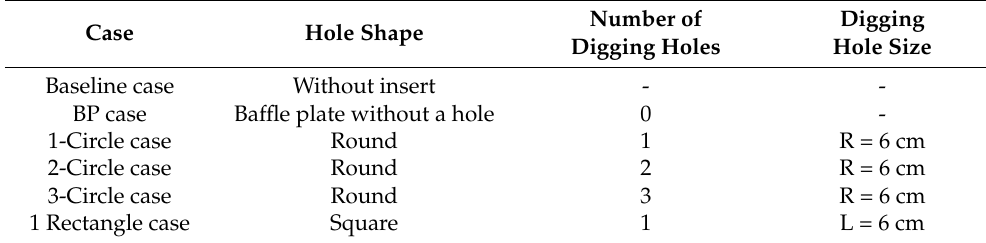
Figure 4. Schematic of the structure of the perforated baffle plate. ( a ) One-circle case; ( b ) two-circle case; ( c ) three-circle case, ( d ) one rectangle case. Table 1. The parameters of the numerical simulation cases.